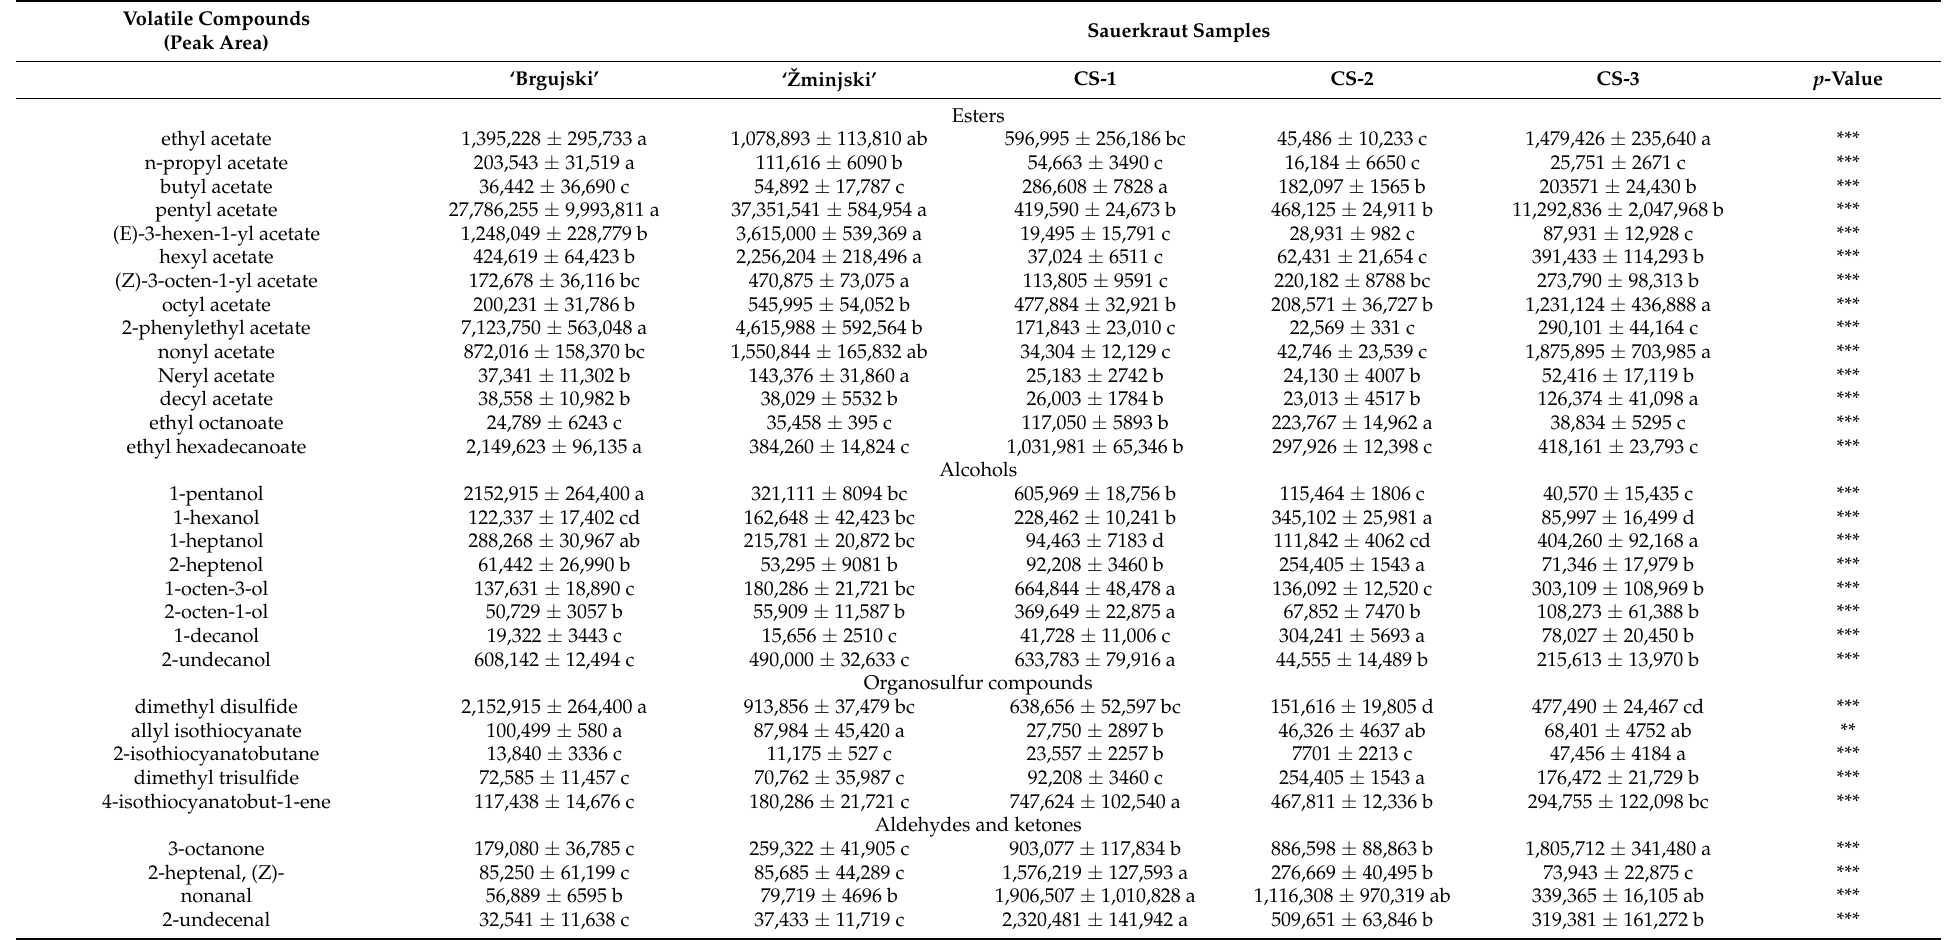
Table 2. Volatile compound contents of sauerkraut samples ‘Brgujski’ and ‘Žminjski’, and commercial sauerkrauts (CS-1, CS-2, and CS-3) (Mean ± SD, n =